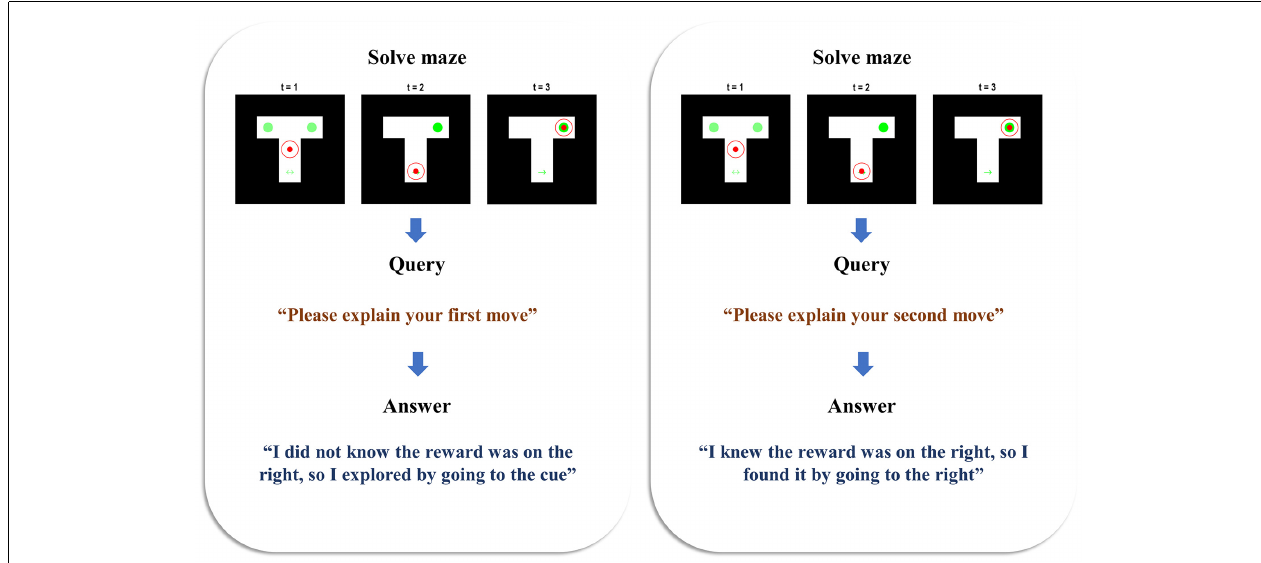
FIGURE 2 | Beliefs and behaviour . This figure reports the results of two simulations—one in which the first move is queried (left), and one in which the second move is queried (right). Each is divided into the three stages of the task. The first row of plots shows the beliefs and behaviour as the maze is solved during the first three time-steps. The small filled red circle shows the position of the agent in the maze. The larger unfilled circle shows the beliefs of the agent about its position. When this is red, this indicates a posterior probability of one of being in that location. As the probability decreases, the red fades to nothing—i.e., a posterior probability of zero of being in that location. In both simulations, the agent maintained confident and veridical beliefs about its location. The beliefs about the context (i.e., reward-left and reward-right) are shown in green, with the intensity of the green colour in the left and right arms (and of the arrows in the cue location) corresponds to the probability assigned to the associated context under the agent’s posterior beliefs. On solving the maze, the agent moves on to the query stage, and the sentence presented to the agent is shown. Finally, the agent has the opportunity to answer the query, and the sentence it generates is shown